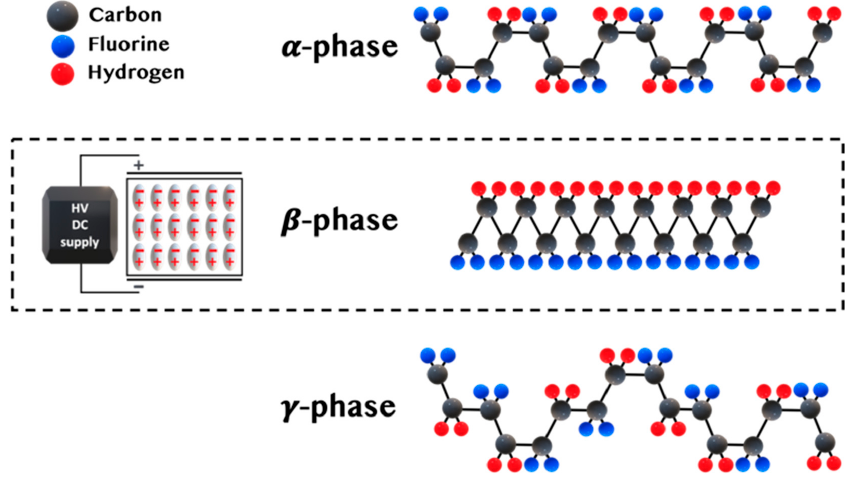
Figure 1. The main phases of polyvinylidene fluoride (PVDF) and β -PVDF induced by stretching and high voltage poling voltage.